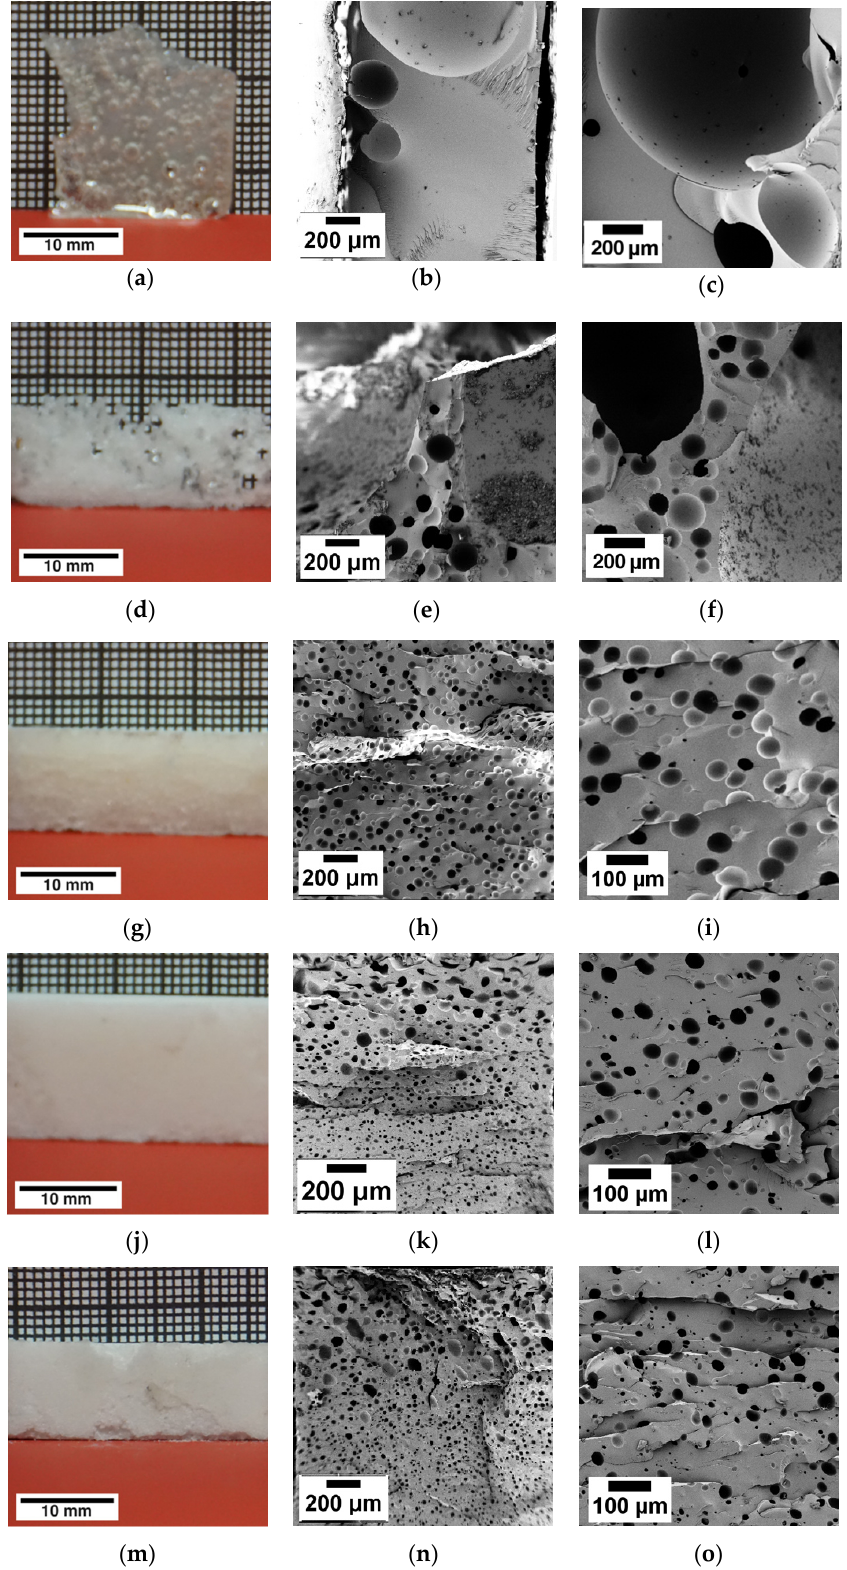
Figure 8. Pictures of the DbI 30/70 w systems which were pre-cured for different times of ( a – c ) 0 h; ( d – f ) 1 h; ( g – i ) 2 h; ( j–l ) 3 h and ( m–o ) 5 h at 60 ◦ C and further cured and foamed for 1 h at 180 ◦ C. The samples in the photos are orientated in expansion direction, except ( a ), which shows the top side view due to low expansion and to illustrate the bubbles formed, and ( b ), which shows the side view to illustrate the low